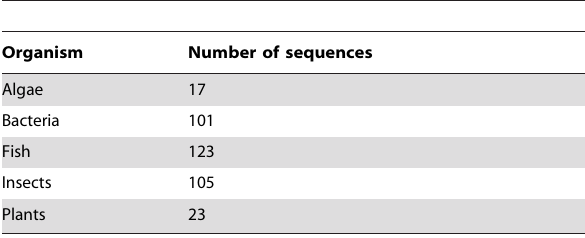
Table 2. Distribution of the 369 AFP sequences between the types of organism in the independent dataset.